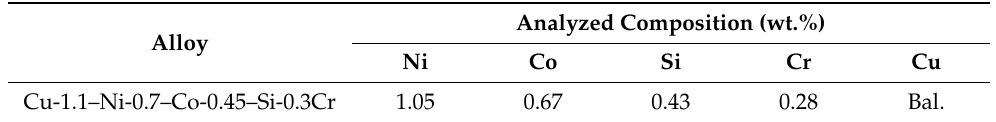
Table 1. The nominal and analyzed compositions of the Cu-1.1–Ni-0.7–Co-0.45–Si-0.3Cr alloy. Analyzed Composition Alloy